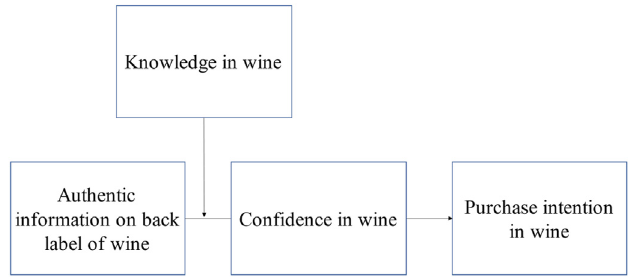
Fig. 2. Conceptual framework of H2b and